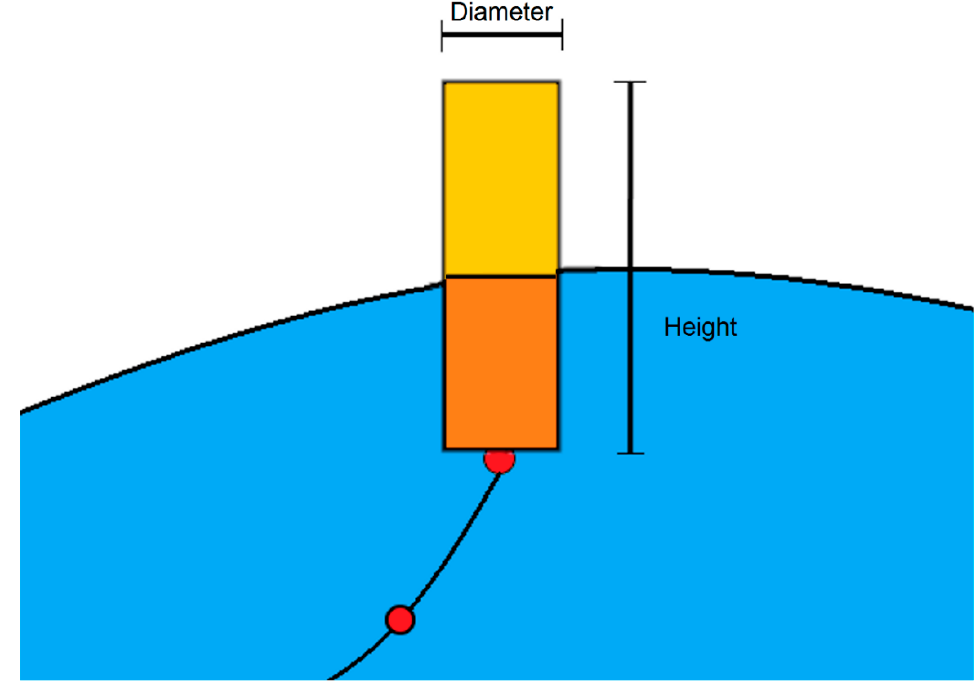
Figure 5. Illustration of the buoy (red circles: Nodes).